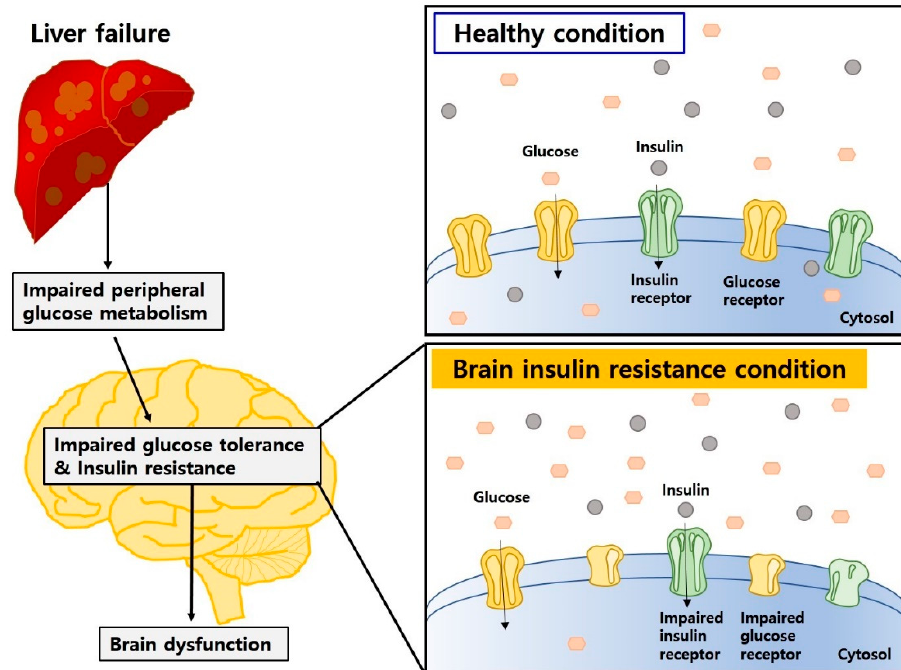
Figure 3. Insulin resistance and impaired glucose metabolism may aggravate brain dysfunction in HE and DE. Peripheral insulin and glucose metabolism can influence brain homeostasis, and impaired glucose tolerance and insulin resistance can cause brain dysfunction in HE and DE.